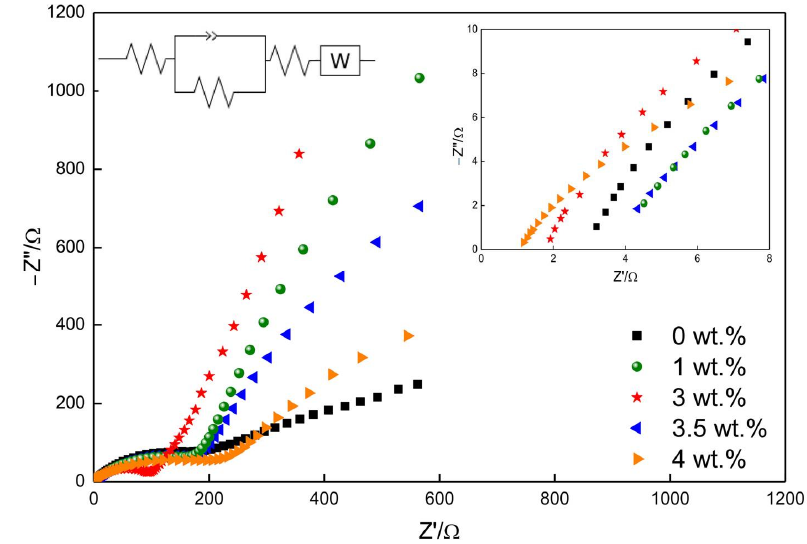
Figure 11. Impedance spectra of Ni-doped TiO 2 nanofibers.